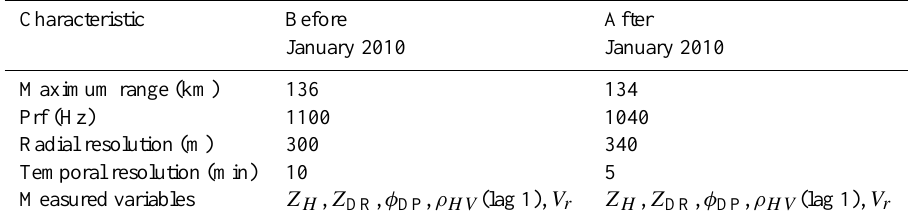
Table 1. Characteristics of the radar Settepani primary